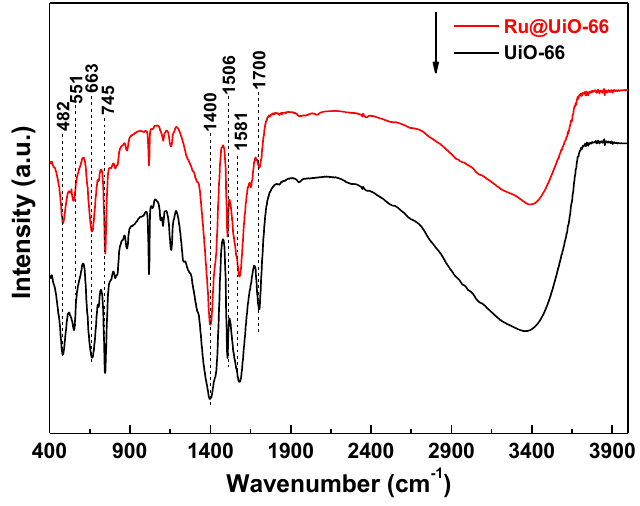
Figure 3. Fourier transform infrared spectroscopy (FTIR) spectra of Ru@UiO-66 and UiO-66.